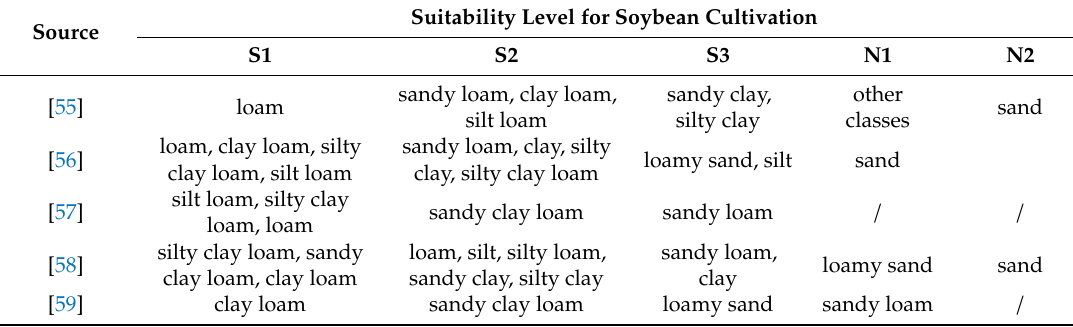
Table2. SoiltexturesuitabilityforsoybeancultivationfrompreviousGIS-basedmulticriteriaanalysisstudies.